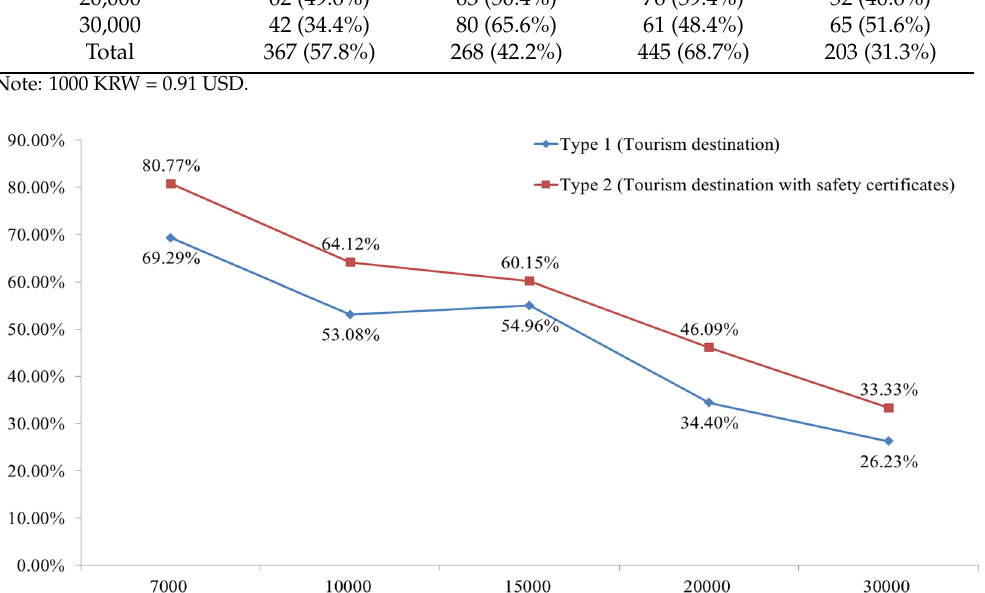
Figure 1. Probability of ‘yes’ response on WTP. Note: X axis is bid value (KRW), Y axis is the percentage of ‘yes’ responses.